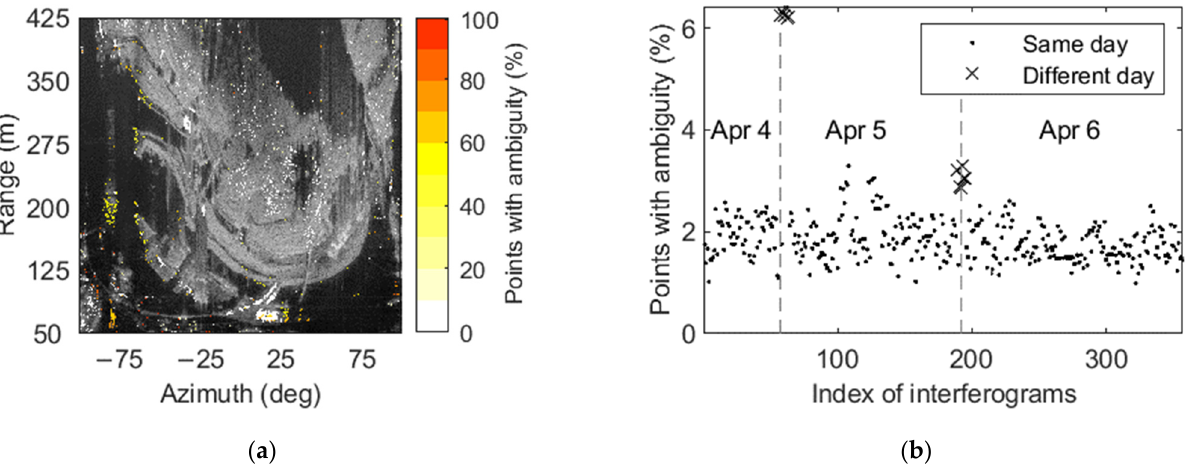
Figure 6. Distribution and proportion of points with a phase change before and after unwrapping, i.e., points with ambiguity, and the base image is an intensity gray image. ( a ) Distribution in the spatial domain, the total number is the number of interferograms. ( b ) Distribution of interferograms, the total number is the number of coherent points in an interferogram.